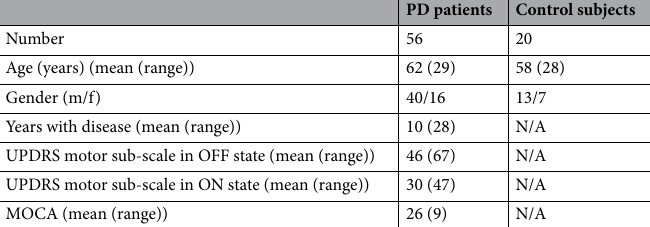
Table 3. Demographics and clinical data for the PD patients and Control